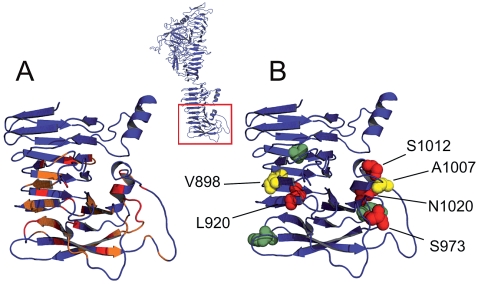
Sequence conservation and transport activity of constructs in the C-terminus of the passenger domain.A. Sequence conservation in linker region of the passenger domain. Residues displaying overall sequence identity are coloured in red, sites showing at least 80% sequence similarity are given in orange. B. Insert positions in transposon mutants highlighted as coloured spheres. Transport-active constructs are illustrated in green, secretion-incompetent mutants are marked in red and constructs displaying residual transport activity are coloured yellow. Insert position is given for transport-inactive constructs.